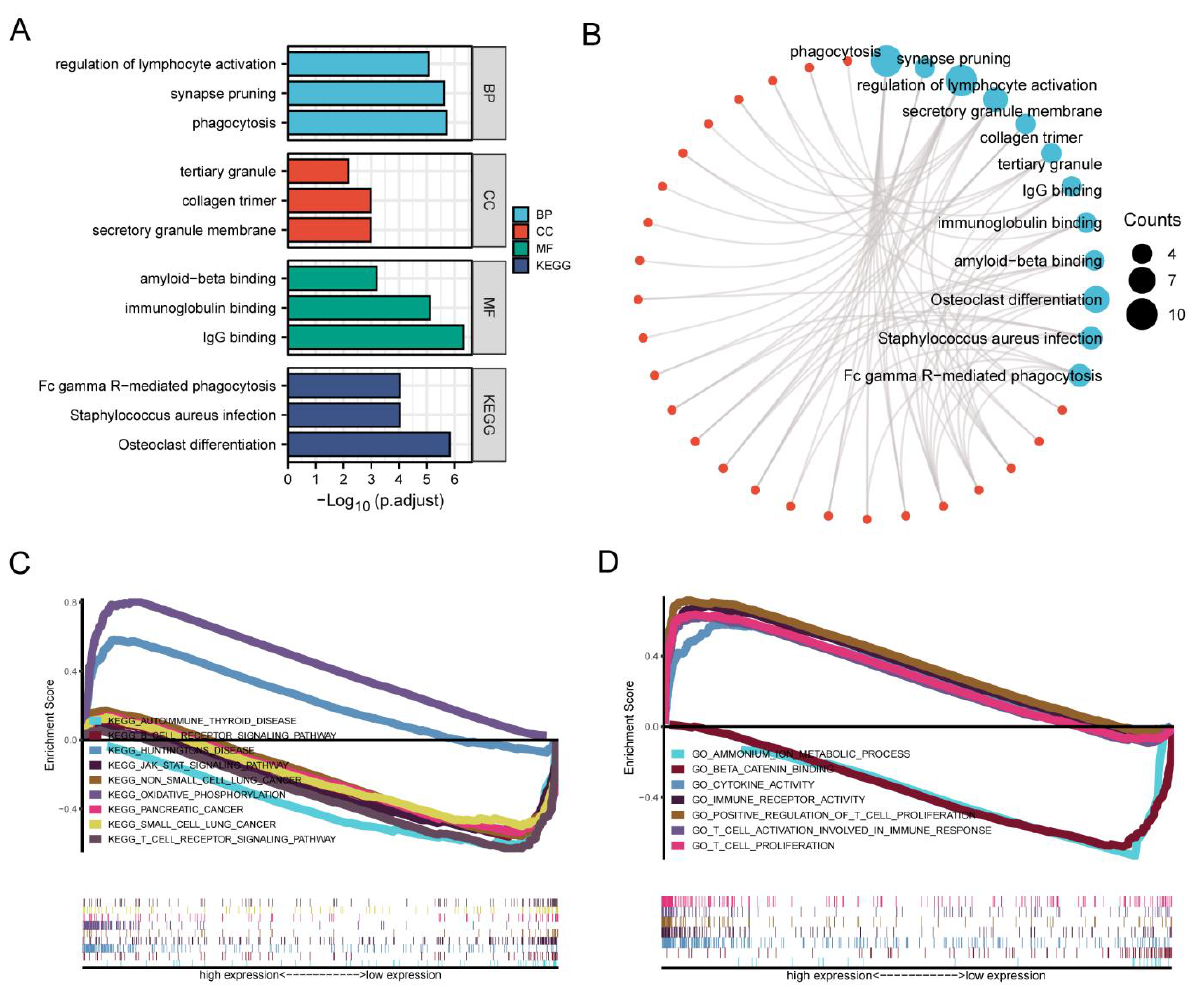
Figure 6. The functional enrichment of HAMP and its co-expressed genes in KIRC. ( A ) Bar plot of the top 3 GO enrichment terms for cellular components, biological processes, and molecular function, and KEGG enrichment terms. ( B ) The function network of GO and KEGG enrichment. ( C , D ) GSEA results, showing the differences in GO and KEGG enrichment between the groups with high and low expression levels in KIRC.